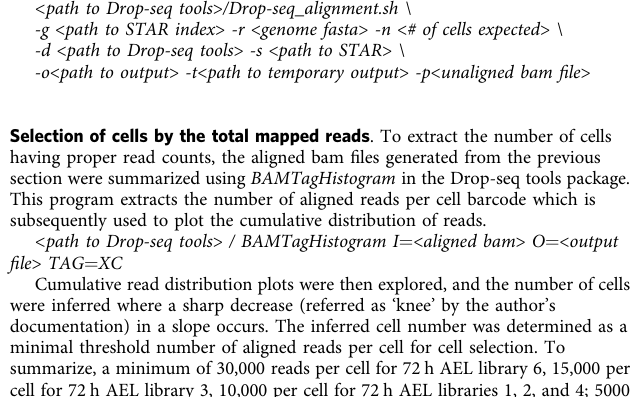
Preprocessing and mapping of scRNA-seq data . Raw scRNA-seq data were generated in paired-end reads following single-cell capture using Drop-seq: one end included a barcode and unique molecular identi fi er (UMI) sequences in 20 nucleotides (12 and 8 nts, respectively), and the other end, cDNA in 50 nts. The